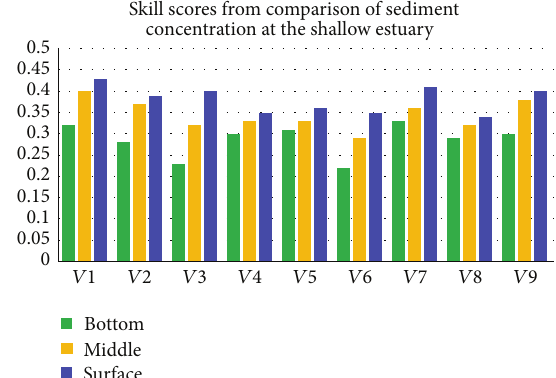
Figure 6: The comparison of suspended sediment concentration for calibration at stations in the Pearl River Estuary is displayed. The skill scores of the surface (blue), the middle (yellow), and the bottom (green) show the good performance of the model with the skill scores of all the stations being above